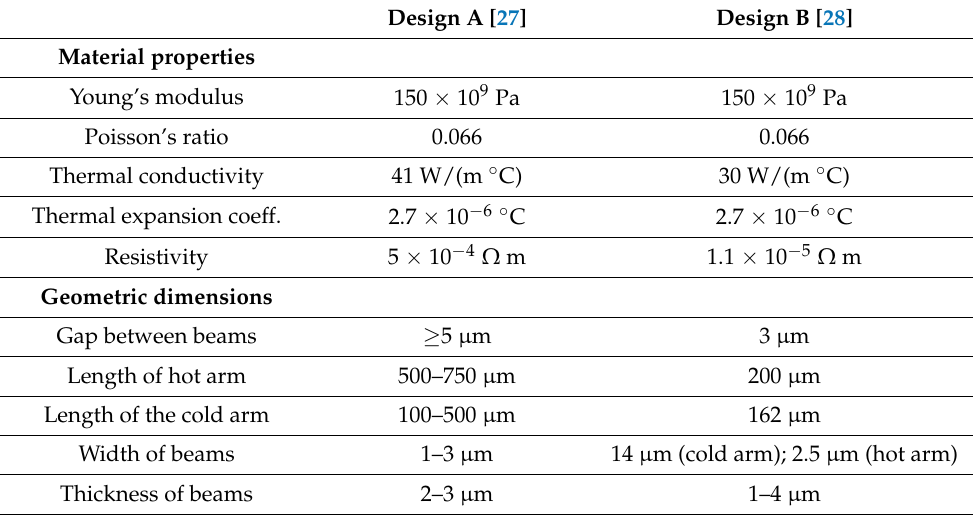
Table 1. Parameters of reference polysilicon